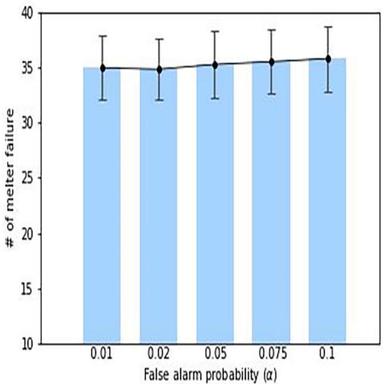
4. The melter failed 35 times given the false alarm probabilities of 0.01, 0.02, 0.05, and 0.075. The melter failed 36 times with the false alarm probability of 0.1. Their standard errors stayed about 3 melter failures.